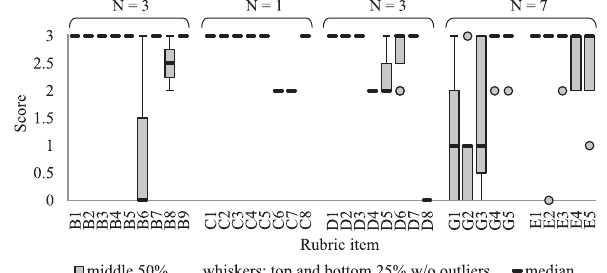
FIG. 4. The scores given to the old reports on each rubric item shown in a box-and-whiskers type diagram. The black line represents the median, it indicates the value under which at least 50% of all reports scored. The gray area is the interquartile range with at least 50% of the scores, and the whiskers are the remaining at most 50% of the scores. The outliers are represented as separate points (gray circles). 1 Rubric C was only used for one report, so there is no distribution of scores. Examples: On rubric item B6, the majority of the scores were 0 (at least 50% — median), while scores reached up to 3. Rubric items G2 and G3 have both at least 50% of the scores between 0 and 1, but G2 has only one outlier with a score of 3, while G3 has between 25% and 50% of the scores between 1 and 3. Therefore, although the median is the same, the distribution of G2 is peaked towards lower scores, while of G3 towards higher scores. Both, however, contain at least one score 3.